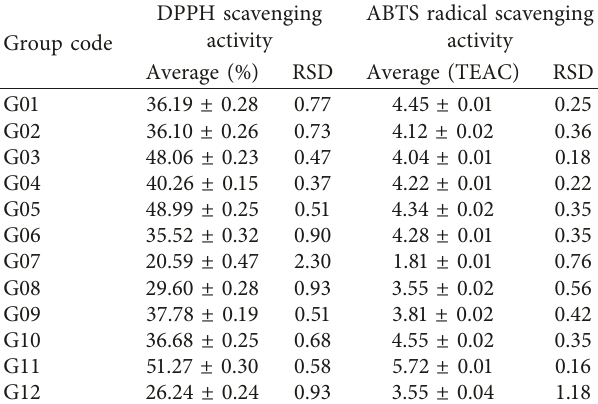
Table 3: The calculation of antioxidant activities from 12 famous green teas by DPPH and